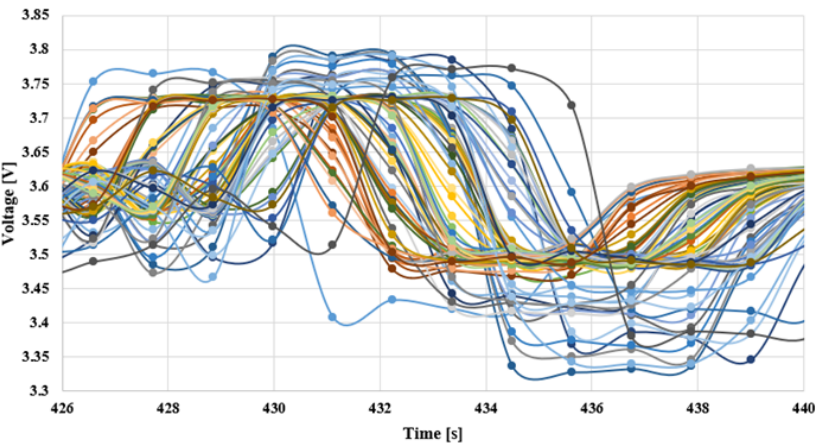
Figure 8. Data slip analysis in a short time range in Dynamic test 2 (the different color lines indicate the 88 battery cells).